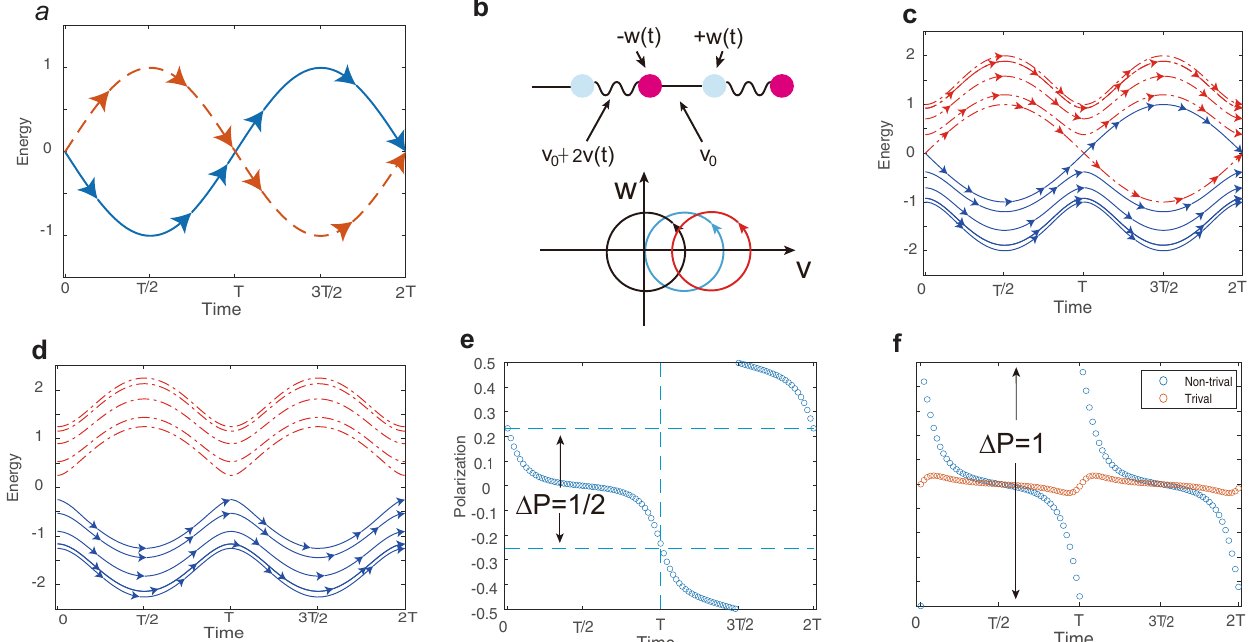
Fig. 2 Topological half-charge pumping. a The two-period time evolution in the two-level system. b The sketch of a half-charge pumping and w ð t Þ ¼ w 0 sin 2 π t and the cyclic evolution in v - w space. The black and red circles mean for the topologically chain with v ð t Þ ¼ v 0 sin 2 ω t 2 T nontrivial case v ð t Þ ¼ (cid:2) v 0 and trivial case v ð t Þ ¼ m þ v 0 sin 2 ω t with m > 0. c The energy dispersion for the gapless one-dimensional þ v 0 sin 2 ω t 2 2 2 chain in Eq. (3) in two time period T . d The energy dispersion for the gapped one-dimensional chain in Eq. (3) with a nonzero mass in v ð t Þ ¼ m þ v 0 sin 2 ω t in two time period T . e Electric polarization as a function of t in two time period T for the gapless one dimensional chain. 2 f Electric polarization as a function of t in one time period T for the gapped cases of v ð t Þ ¼ m þ v 0 sin 2 ω t and v ð t Þ ¼ (cid:2) v 0 þ v 0 sin 2 ω t 2 2 2 Fig. 2b (upper panel),